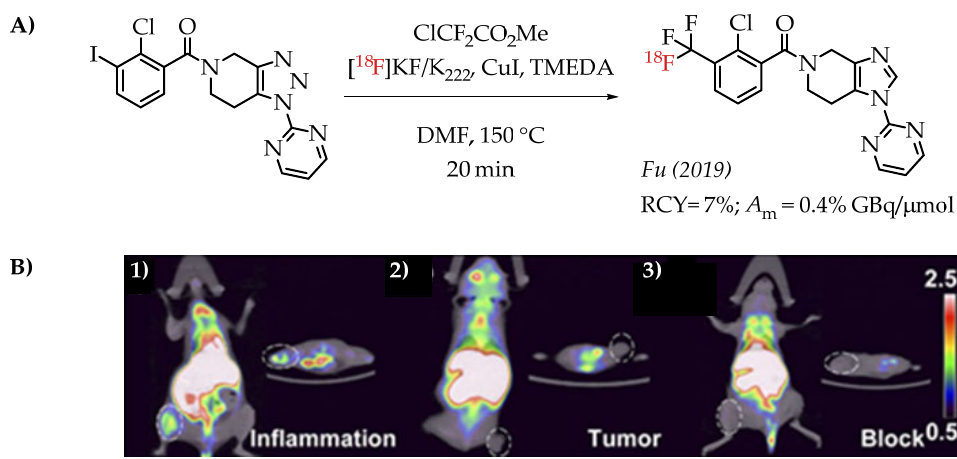
Figure 10. ( A ) Radiosynthesis of [ 18 F]PTTP by Fu et al. ( B ) Small ‐ animal PET/CT imaging of